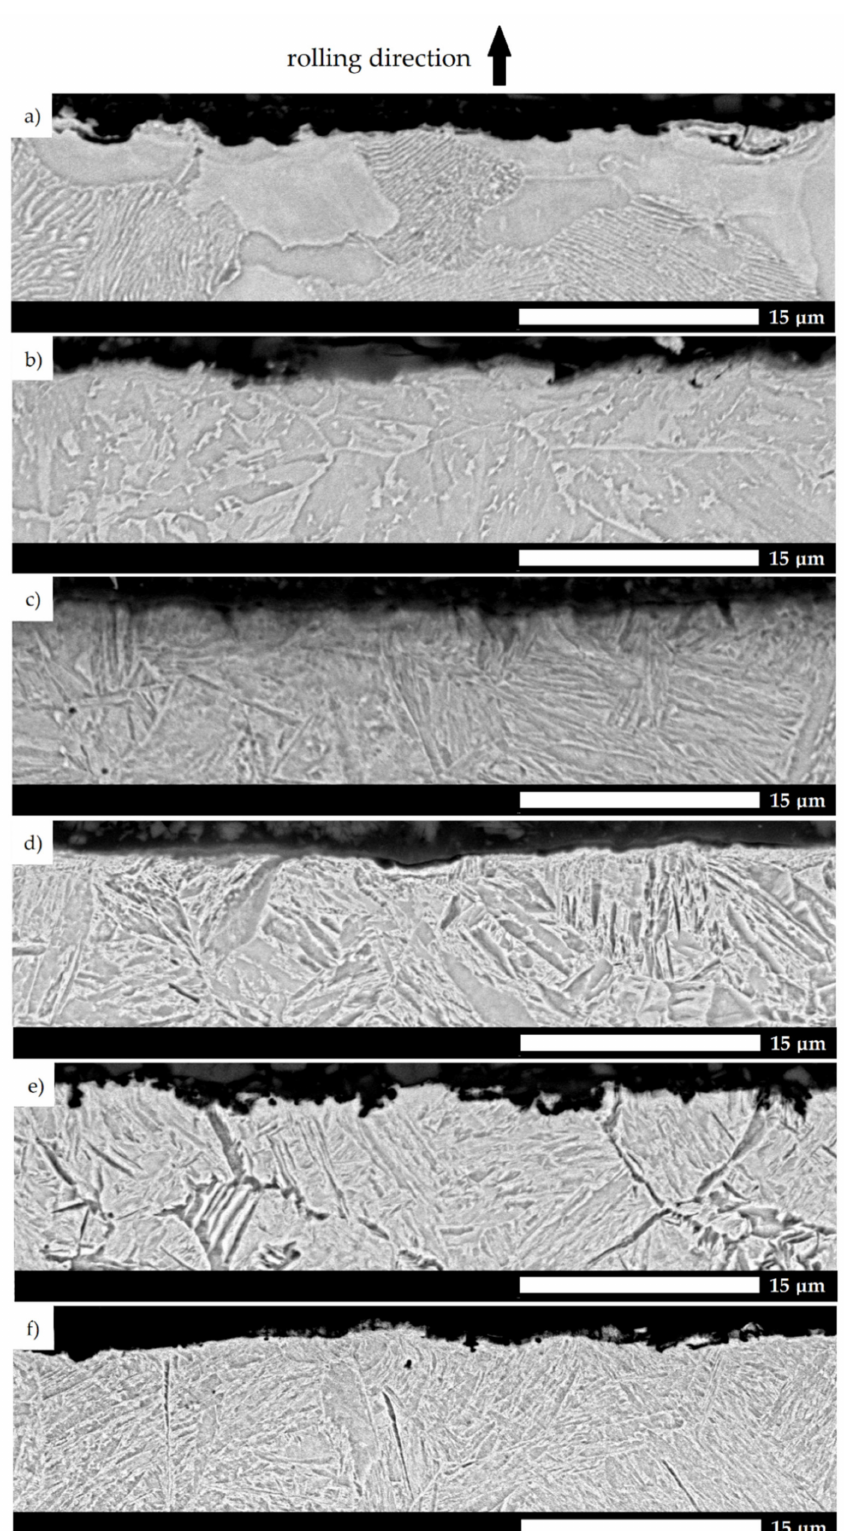
Figure 11. Sub-surface microstructures taken transverse to the direction of abrasive action. ( a ) 38GSA (N); ( b ) Creusabro 4800; ( c ) Creusabro 8000; ( d ) TBL PLUS; ( e ) XAR 600; ( f ) 38GSA (HT). SEM, etched with 5%HNO 3